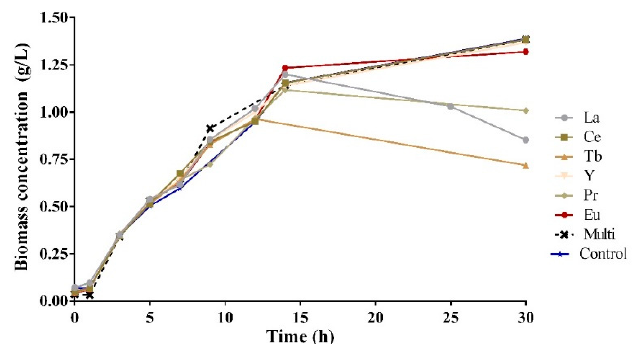
Figure 1. Biomass concentration (g/L) versus time (h), for an initial concentration of 20 mg/L for single REE, multi REE, and control.